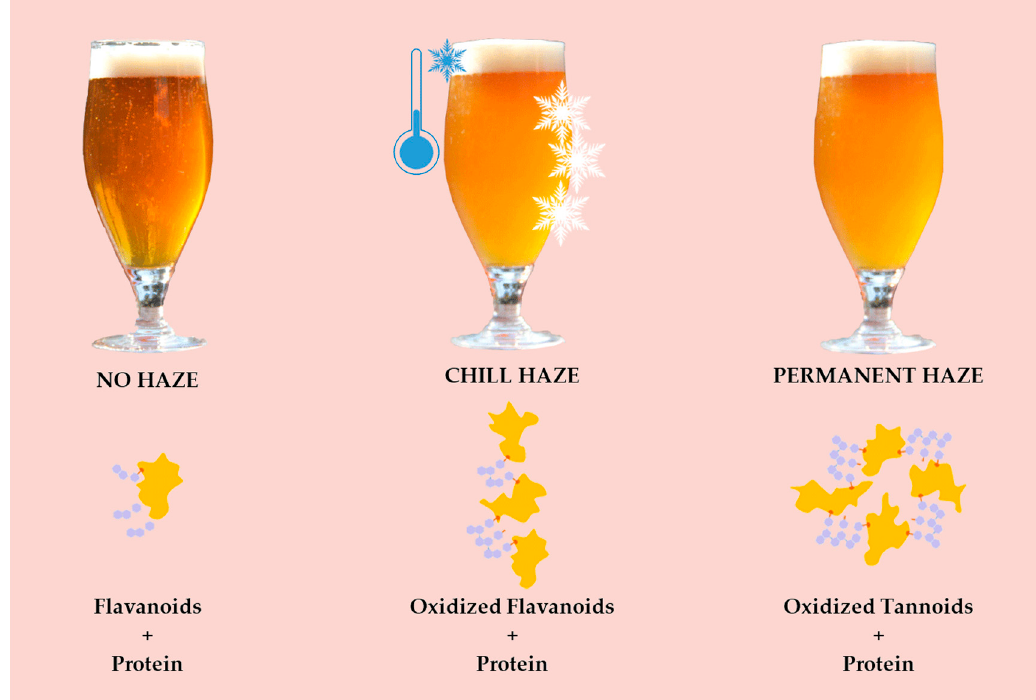
Figure 2. Chill and permanent haze development in beer. Adapted from [37].